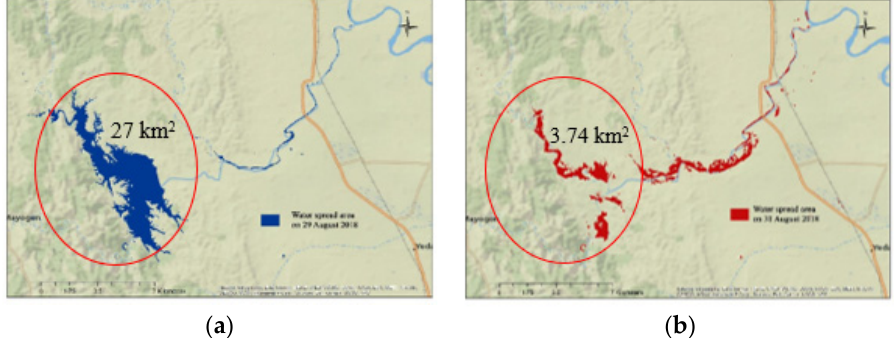
Figure 9. Water spread area ( a ) before (blue) and ( b ) after (red) the breach of the Swa Dam.